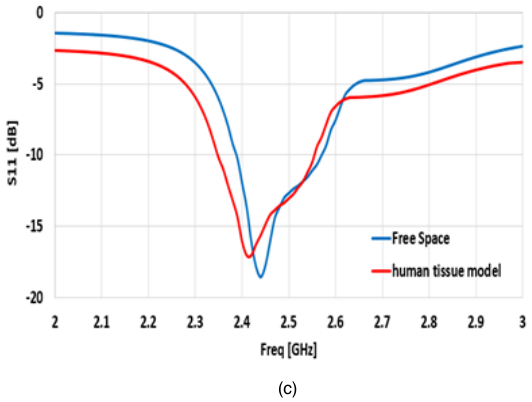
FIGURE 13. Simulated 1-g averaged SAR distributions (a) SAR Human Model (b) 1-g SAR values (c) S11 Free space Vs humun tissue model The reference input power of 100 mW produces SAR distribution as shown in Figure 13. The simulated SAR value of antenna are 0.02 W/kg for 1 g of tissue at 2.45 GHz which is substantially below the FCC limit of 1.6 W/kg. The resonant frequency of the antenna gets slightly affected when mounted on the human tissue model.